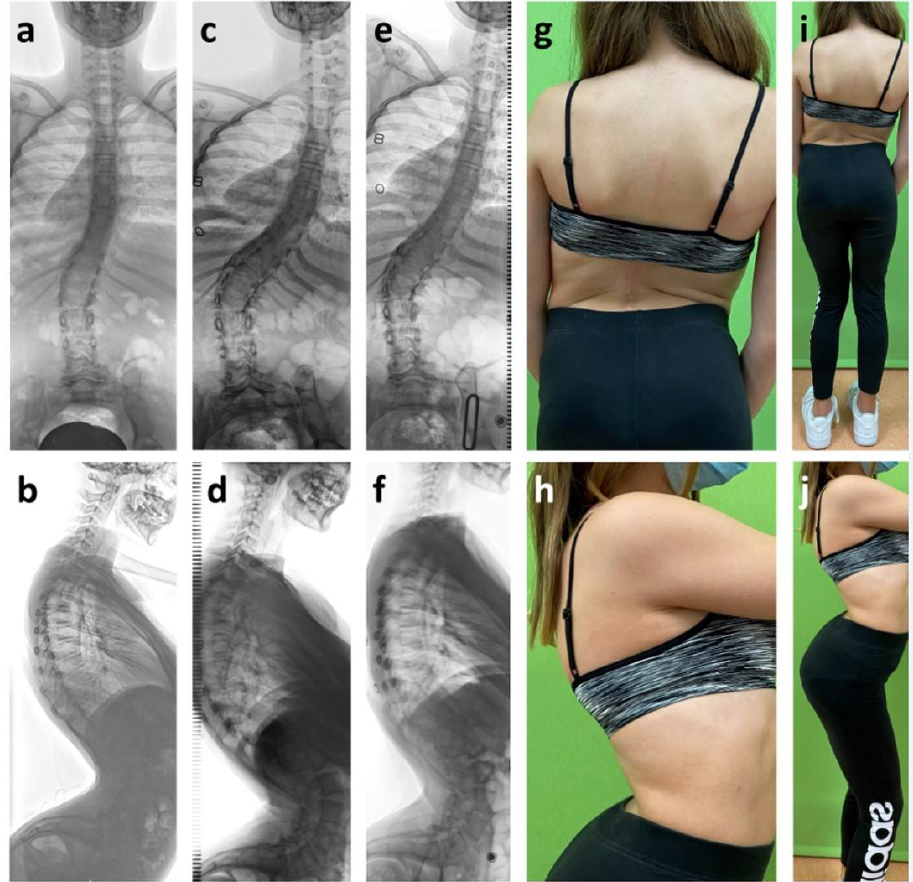
Figure 6. Girl with intramedullary glioma WHO I° from T8 to L3, which was initially diagnosed